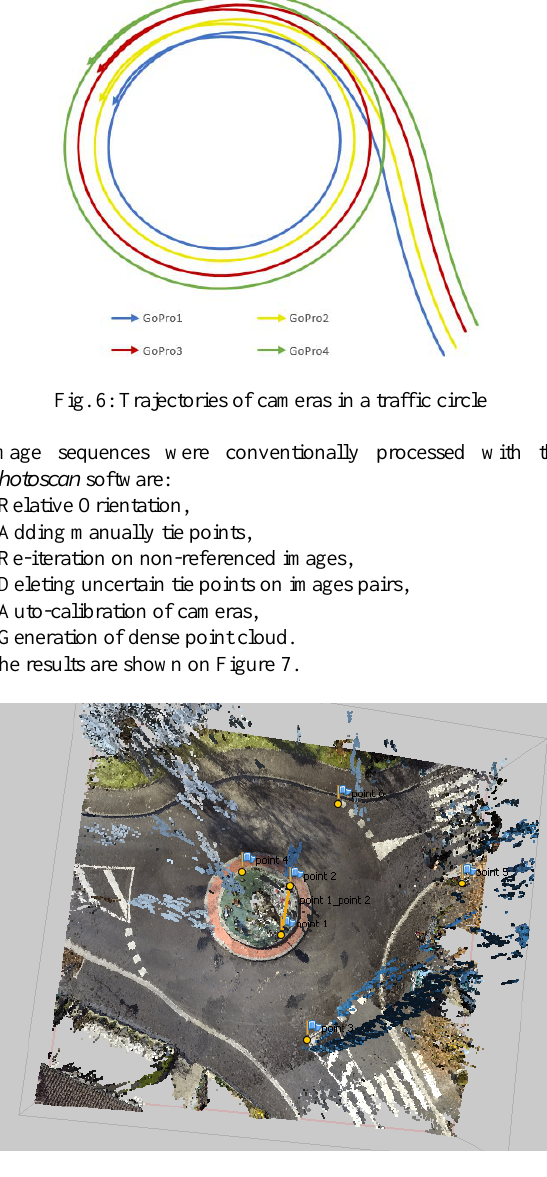
Fig. 7: Point cloud from processing of the images in the case of a traffic circle (Test